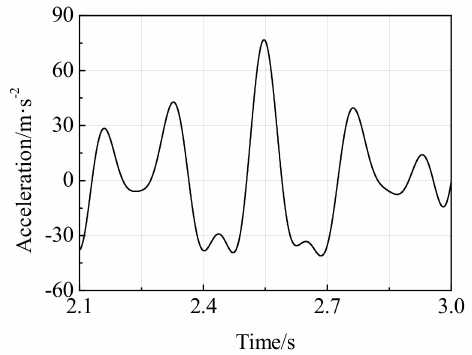
Figure 3. Acceleration waveform diagram containing bogie information.